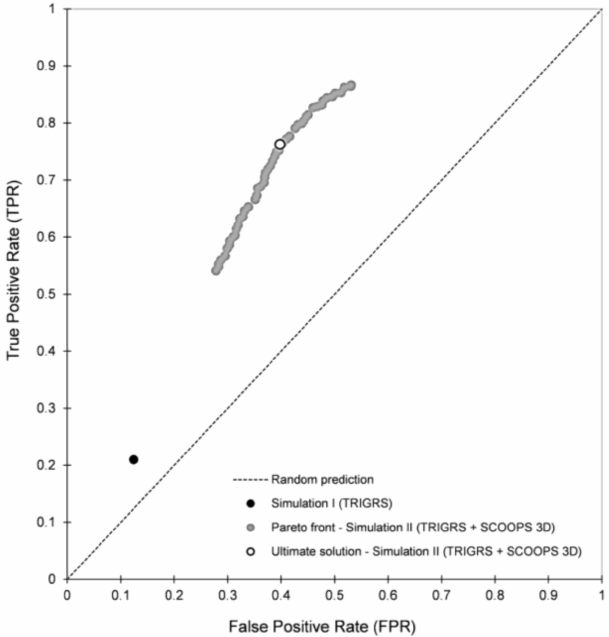
Figure 8. Comparison of the results of TRIGRS and SCOOPS 3D in the false positive rate (FPR)–true positive rate (TPR) space. Selection of the ultimate solution of SCOOPS